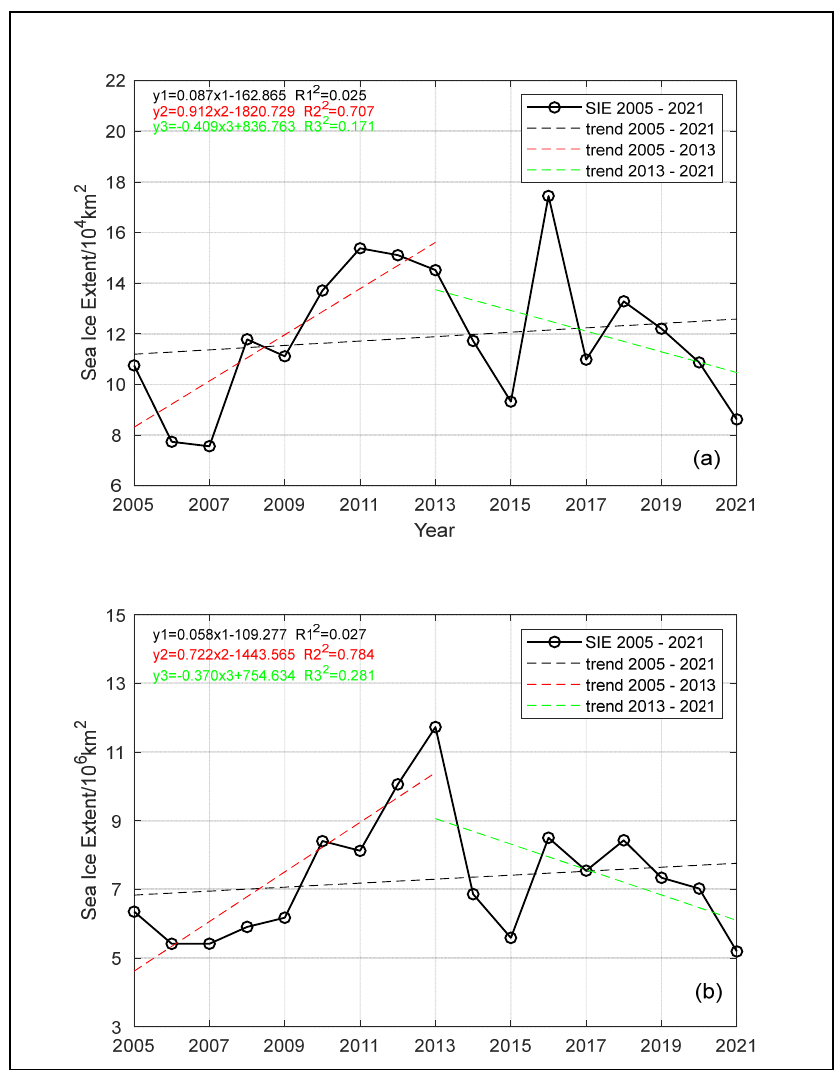
Figure 5. Annual maximum sea ice extent ( a ) and total sea ice extent ( b ) in the marginal seas of East Asia from 2005 to 2021. Table 2. Trends in the total sea ice extent in the marginal seas of East Asia (unit: 10 7 km 2 /10 yr).